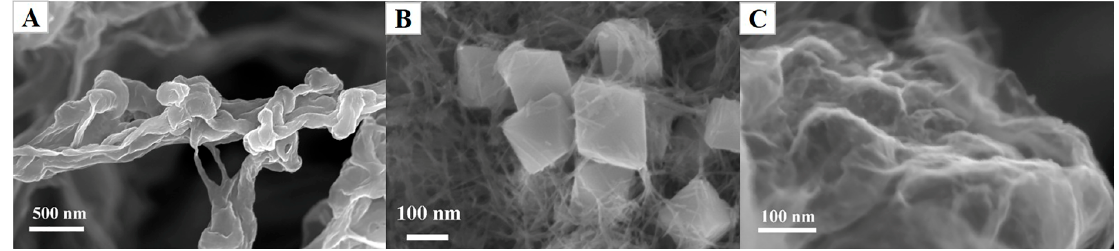
Figure 1. SEM images of RGO ( A ), Cu 2 O ( B ) and Cu 2 O-RGO composite nanoparticles ( C